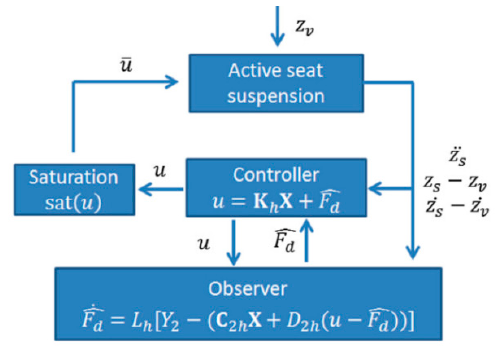
Figure 14. Block diagram of the Takagi–Sugeno (TS) controller with a disturbance observer [60].